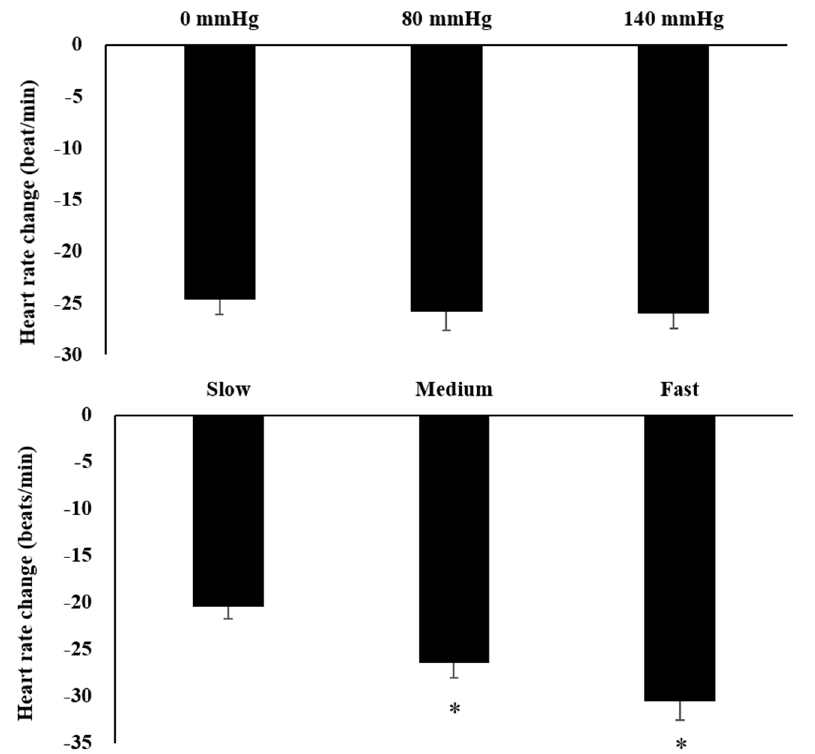
Figure 5. Main effects of heart rate on various pressure and rowing cadence conditions during the recovery period (mean ± SE). * Significantly different from a low cadence.